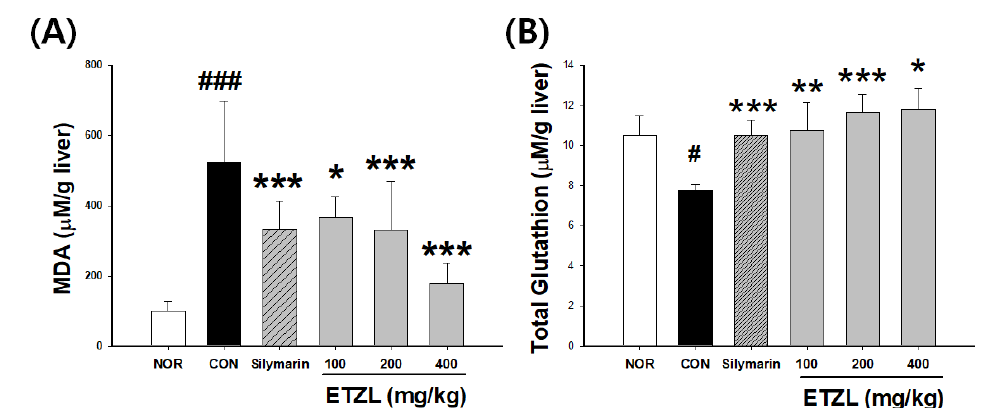
Figure 4. Effect of ETZL on ( A ) MDA and ( B ) GSH levels in liver tissue of binge rats. SD rats